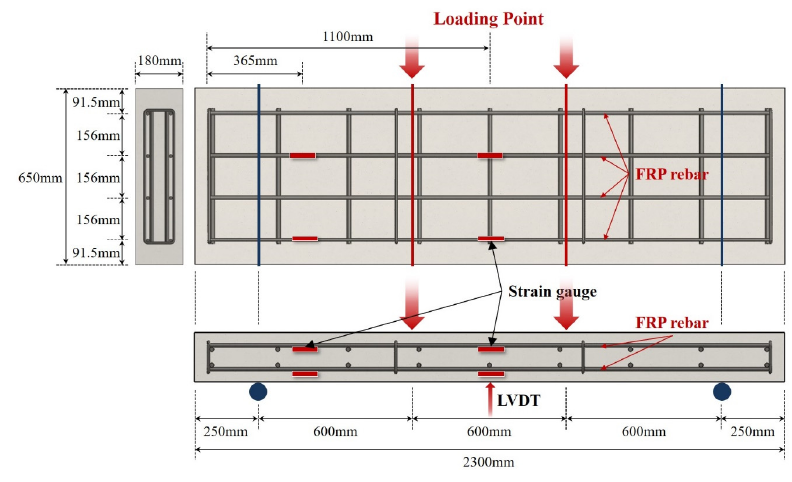
Figure 4. FRP-reinforced concrete slab section.